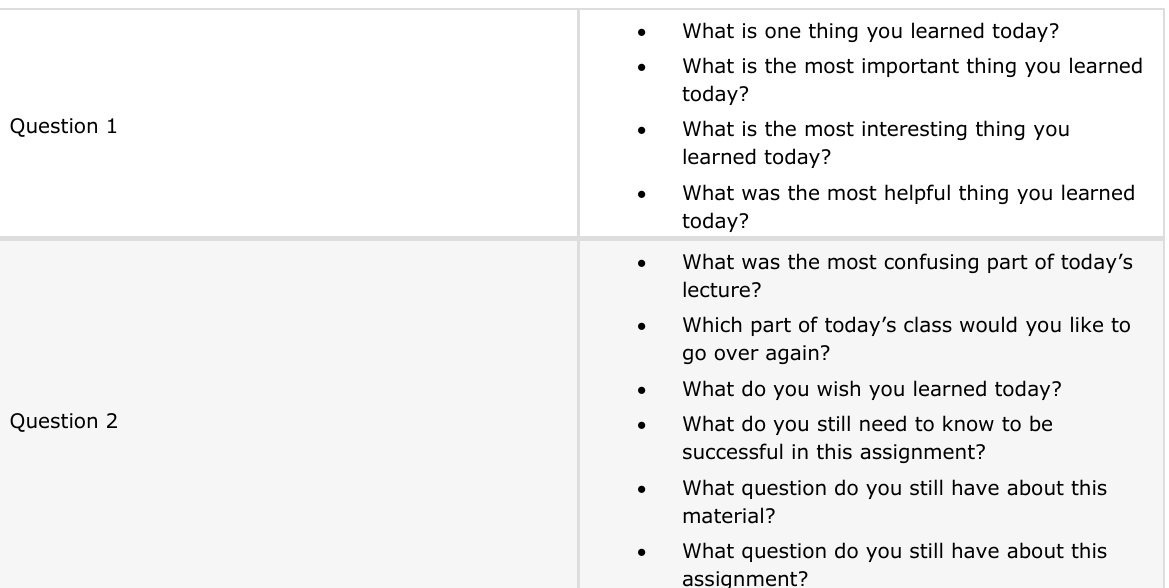
Other Potential Variations Generated by the